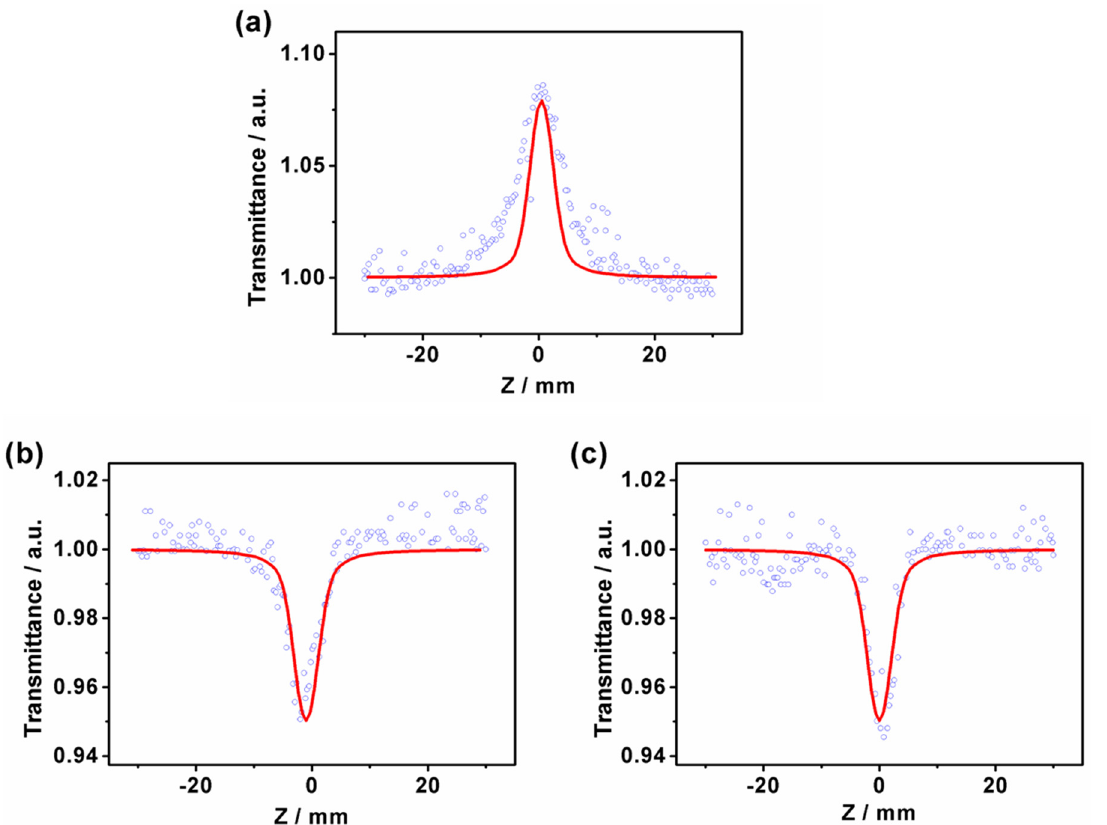
Figure 6. Open-aperture Z-scan curves of compound ( a ) PY-C16, ( b ) PY-C16-TCNE and ( c ) PY-C16- TCNQ.